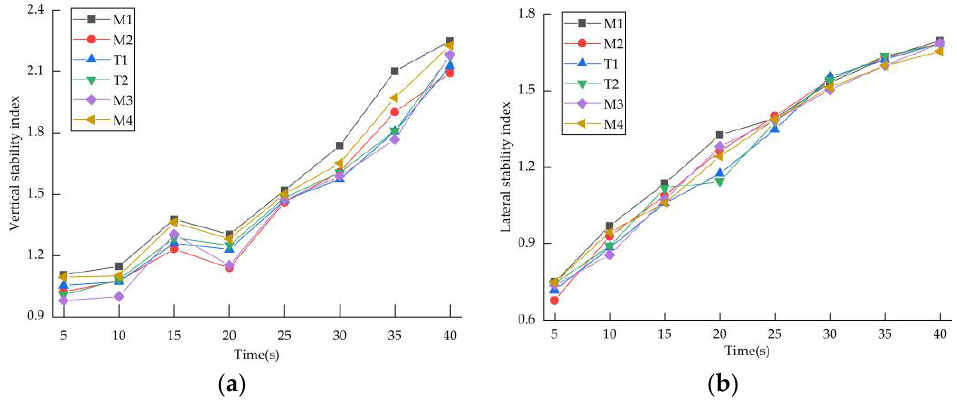
Figure 13. Sperling index of the marshaling urban rail train: ( a ) vertical sperling index; and ( b ) lateral sperling index.